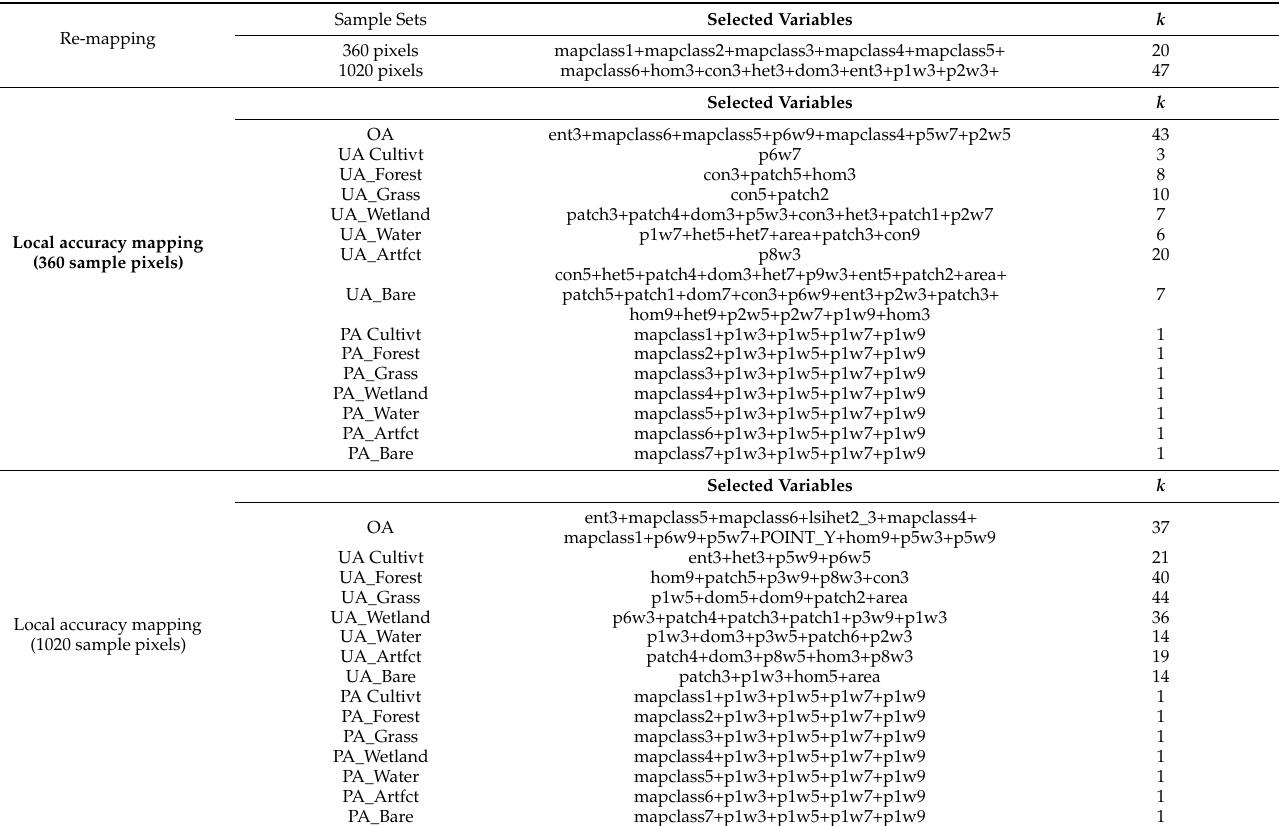
Table A2. Selected explanatory variables and optimum k for KNN (Method CCA-separate).